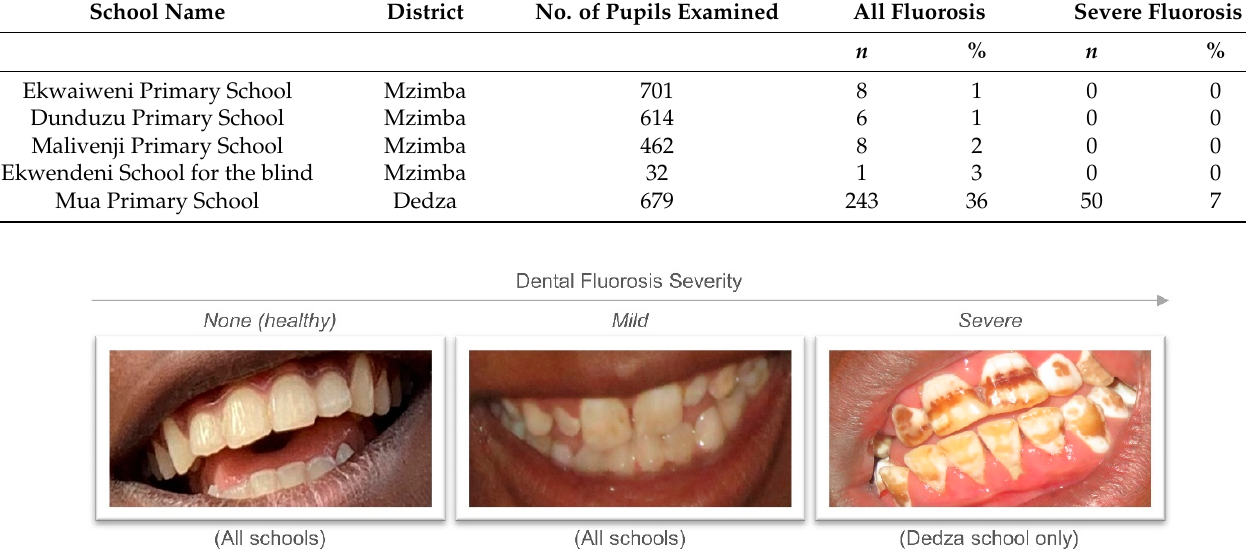
Figure 7. Examples of photographic images of school children’s anterior teeth from the Smileawi/University of Glasgow dental survey showing increasing severity of dental fluorosis. Severe dental fluorosis was only found at Mua Primary School in Dedza District. Dental fluorosis at mild levels appears as small, white opacities of teeth with minimal concern, however at moderate levels teeth can be mottled and cause aesthetic concern. More severe levels can lead to pitting and staining of enamel with loss of enamel integrity leading to tooth breakdown [31]. Table 3. Number and Percentage of children with dental fluorosis and severe dental fluorosis at each of the schools which were sampled by both dental and groundwater sampling teams. Percentage values for ‘all fluorosis’ and ‘severe fluorosis’ reflect the proportion of the total number of pupils examined at each school in each case.